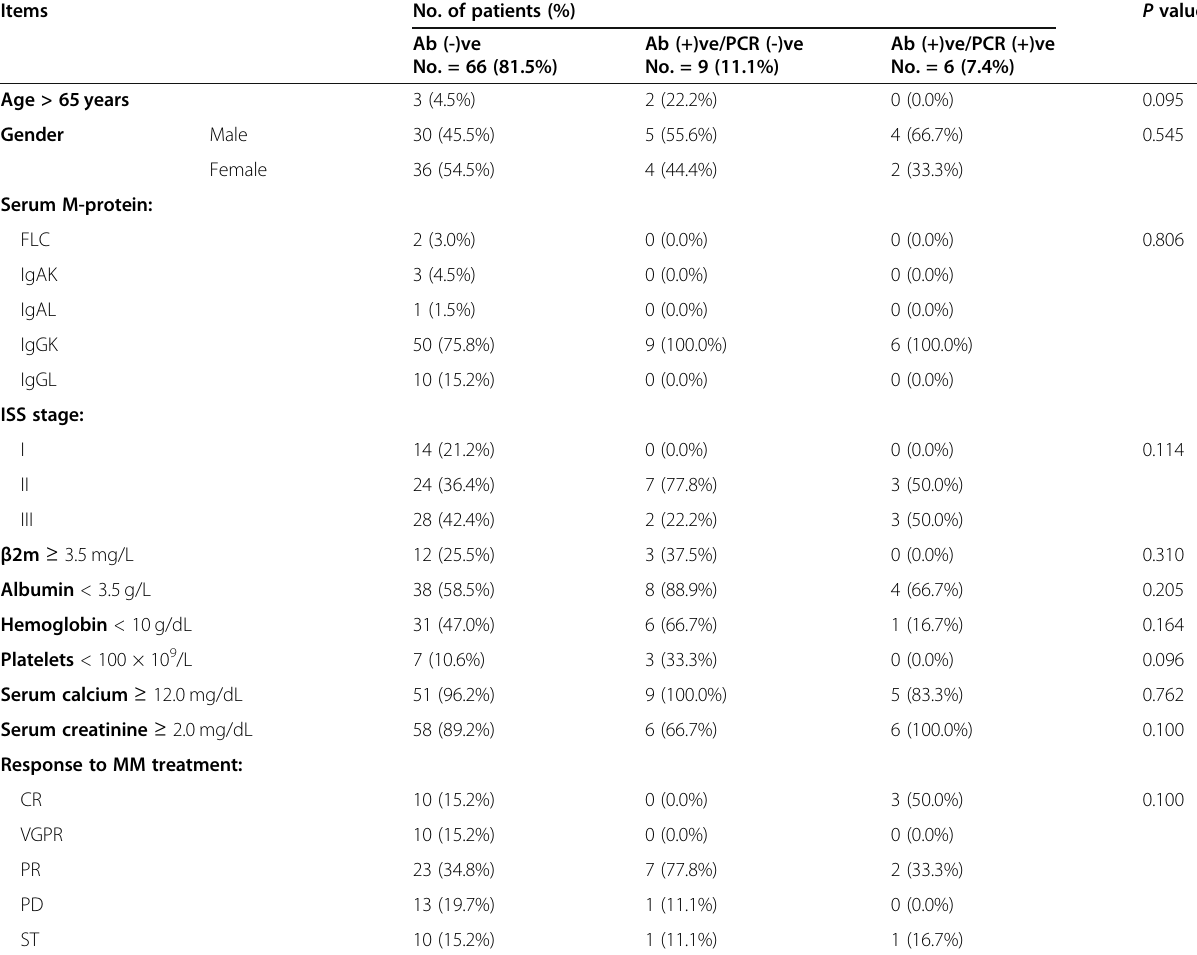
Table 1 Characteristics of 81MM patients according to their HCV